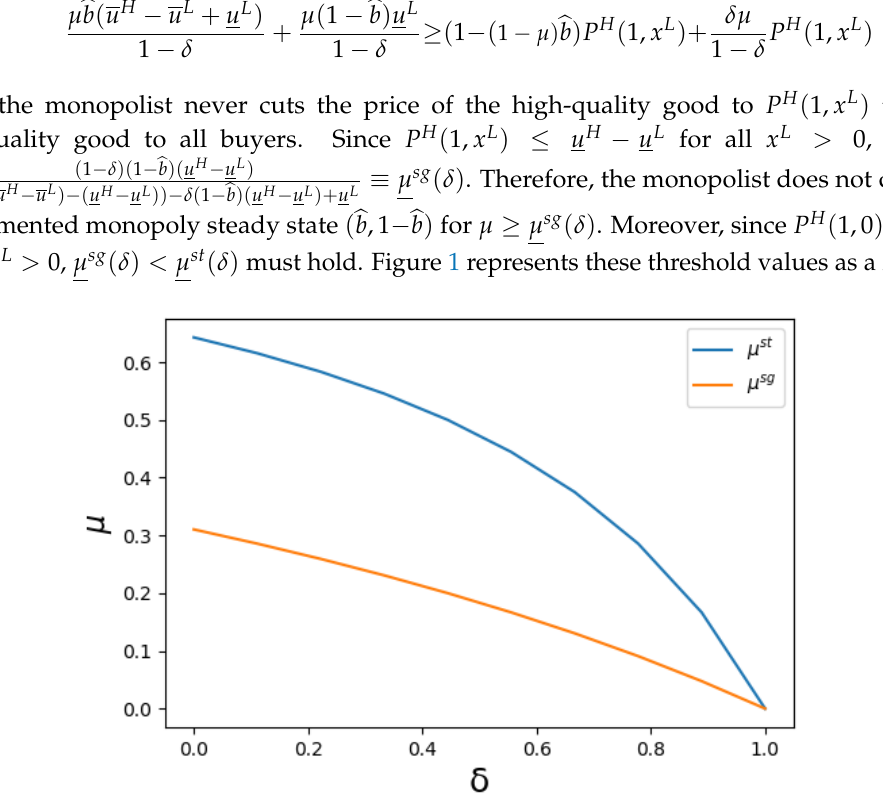
Figure 1. The threshold values for the failure probability µ